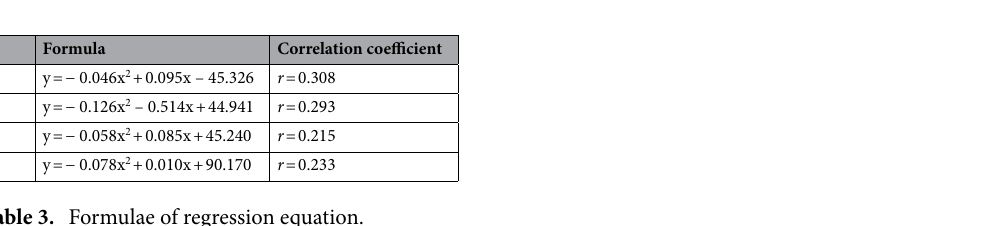
Table 3. Formulae of regression equation.